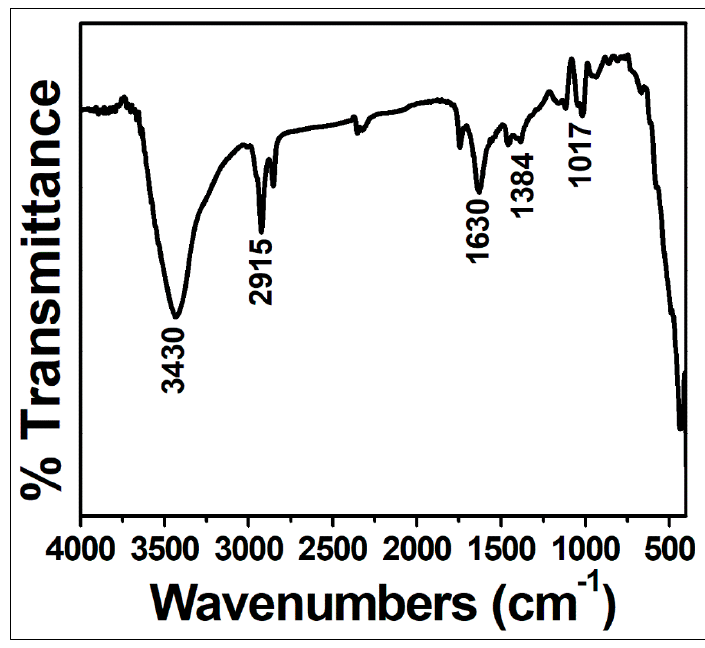
Figure 3. FTIR spectrum of biologically fabricated Ni/NiO NPs using leaves extract of Gymnema sylvestre .